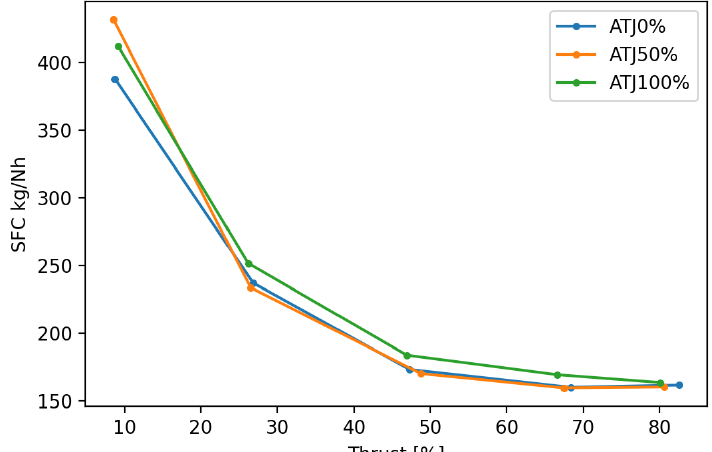
Figure 12. GTM-140/ATJ: SFC.